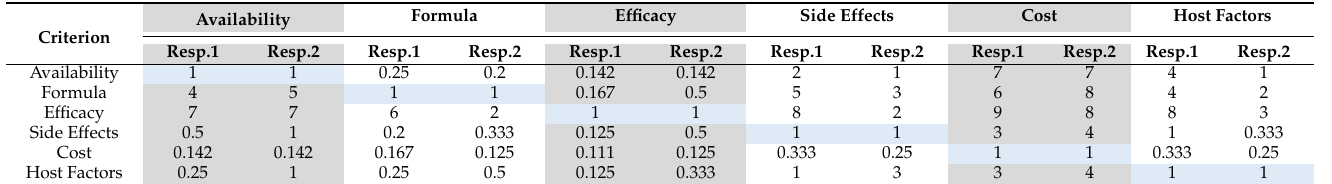
Table 1. Comparison matrix of model input for the six comparison criteria (Respondents 1 and 2).